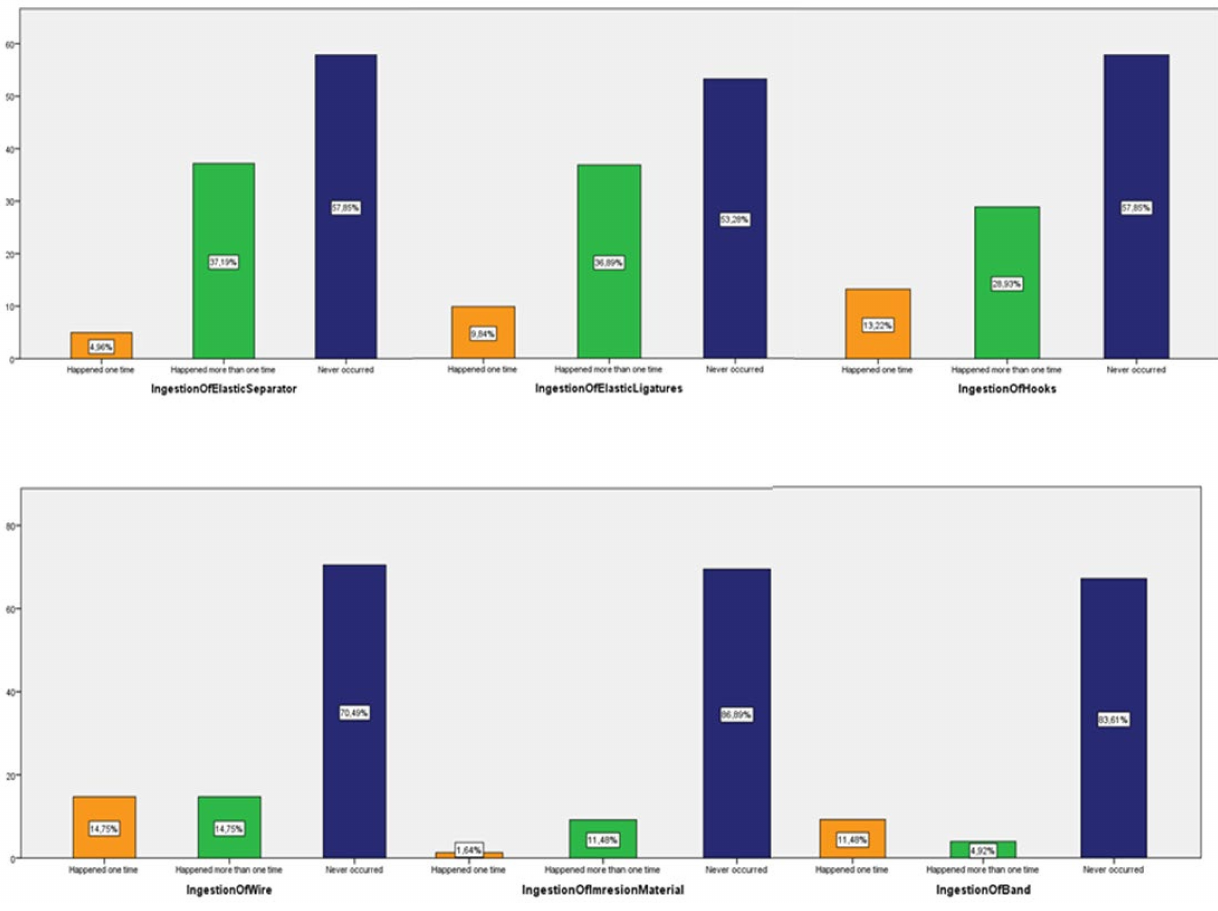
Figure 5. Ingestion